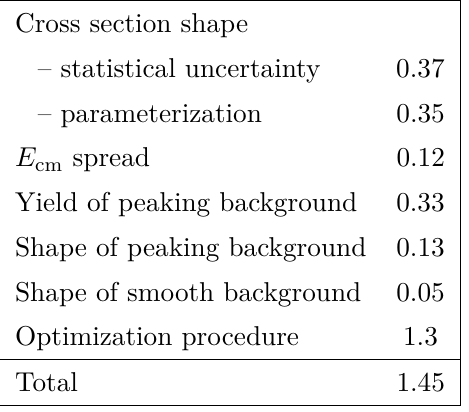
Table 4 . Systematic uncertainties in the total signal yield N total at Υ(5 S ) (in